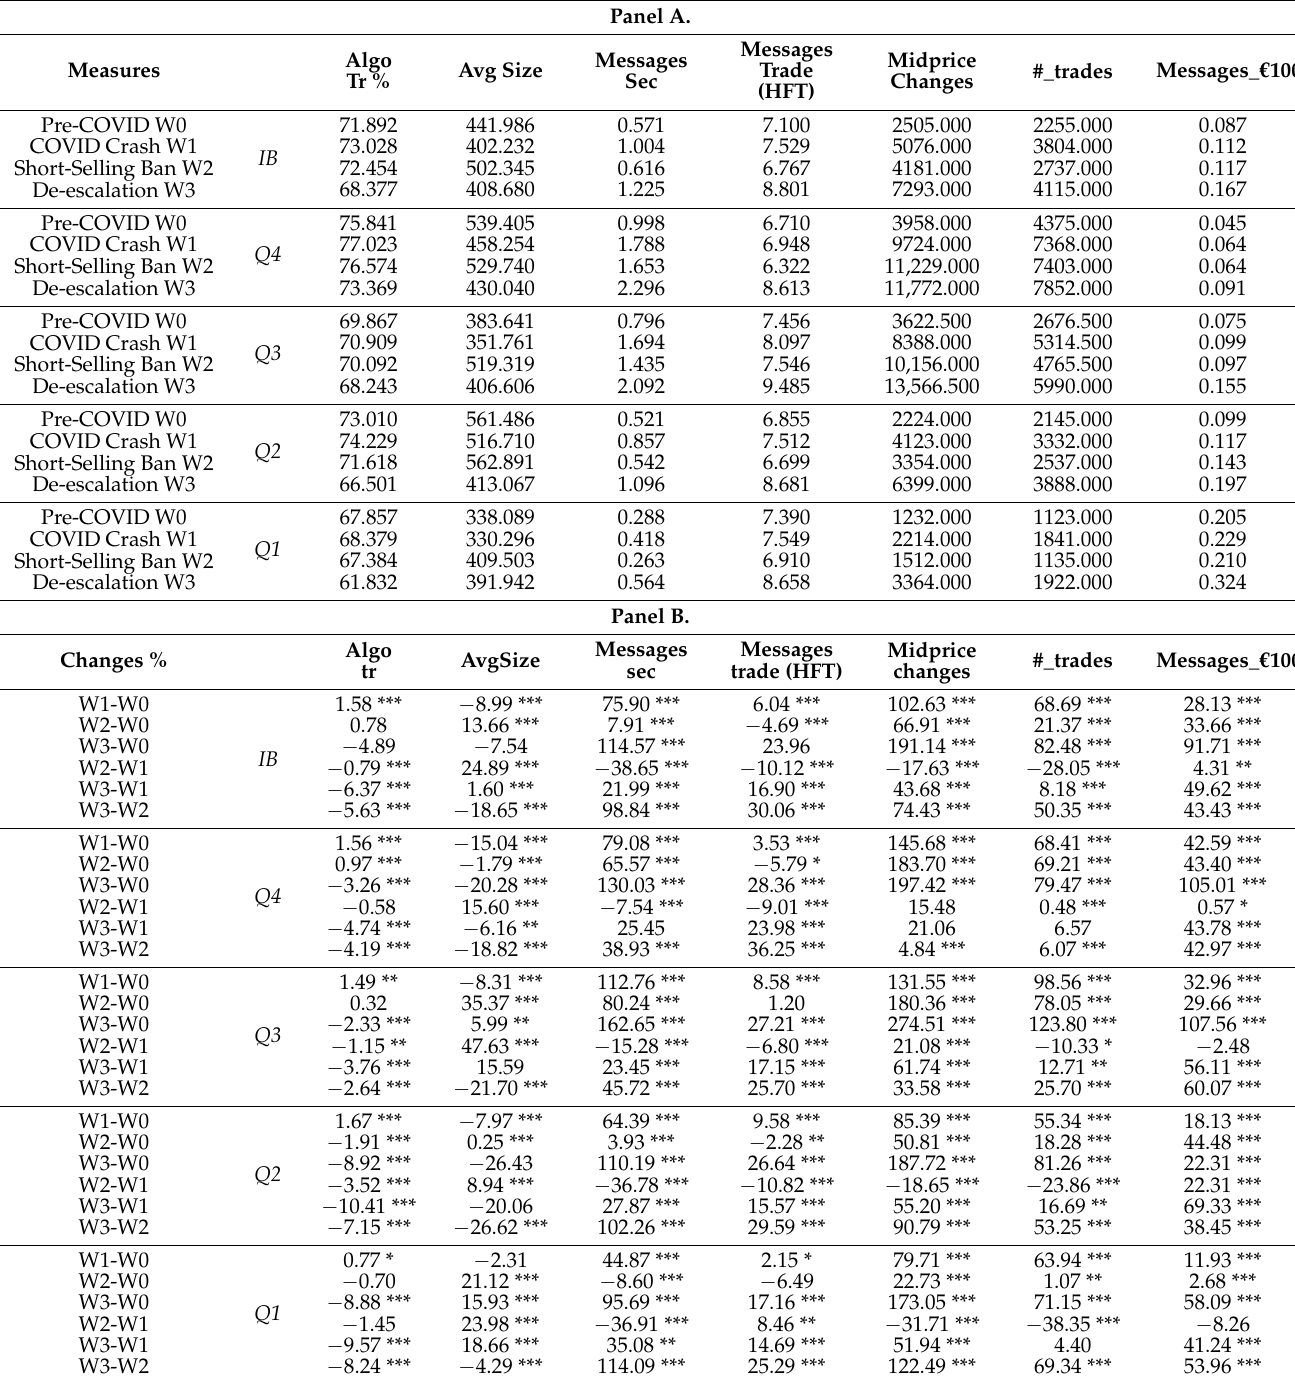
Table 1. Panel A. Algorithmic data and high-frequency trading proxies. Panel B. Changes in median: algorithmic data and high-frequency trading proxies. Panel